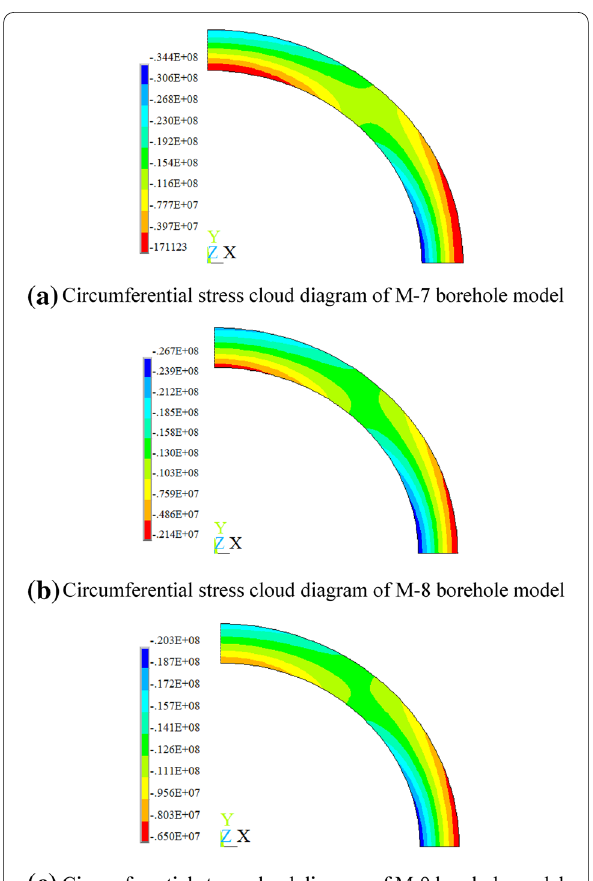
Fig. 6 Circumferential stresses of different borehole wall models when λ =